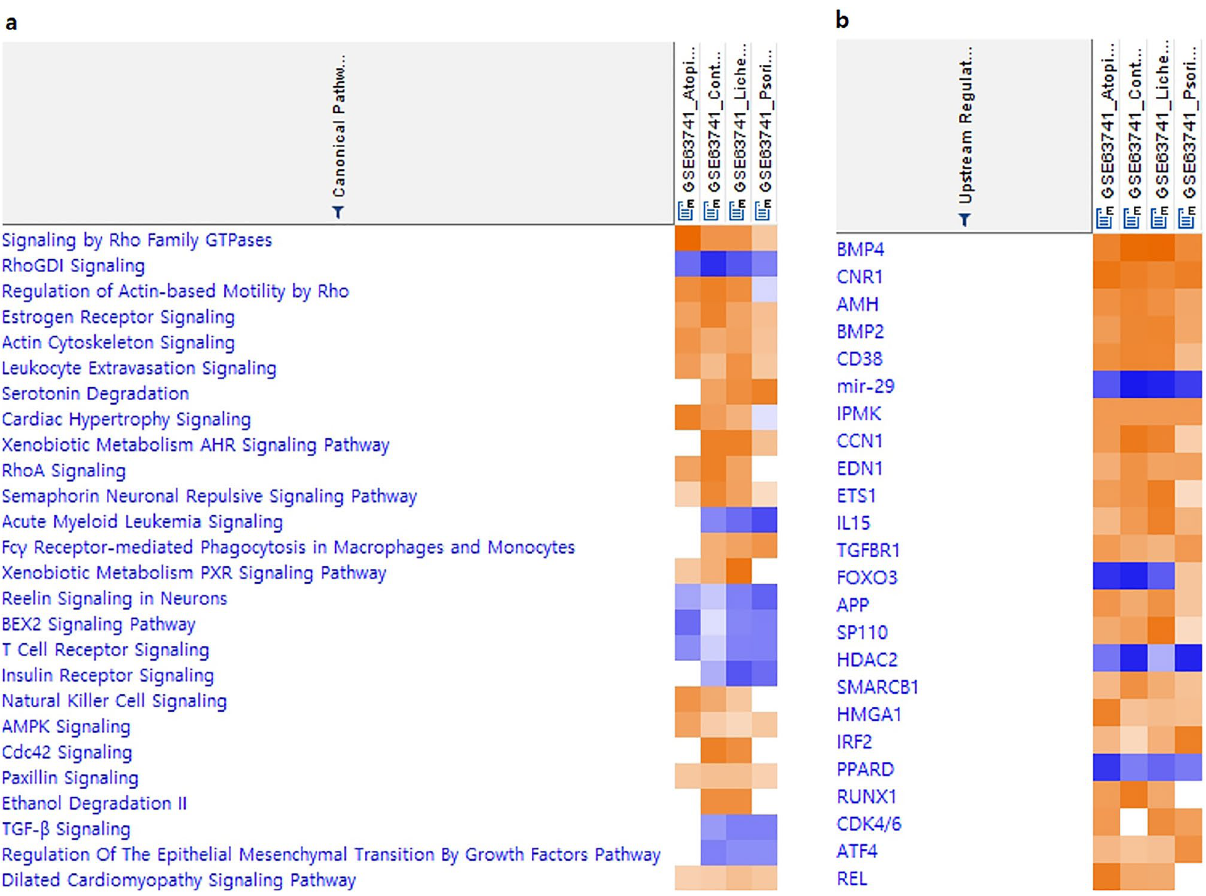
Figure 2. Comparison analysis ( a ) canonical pathways (CP), ( b ) upstream regulators